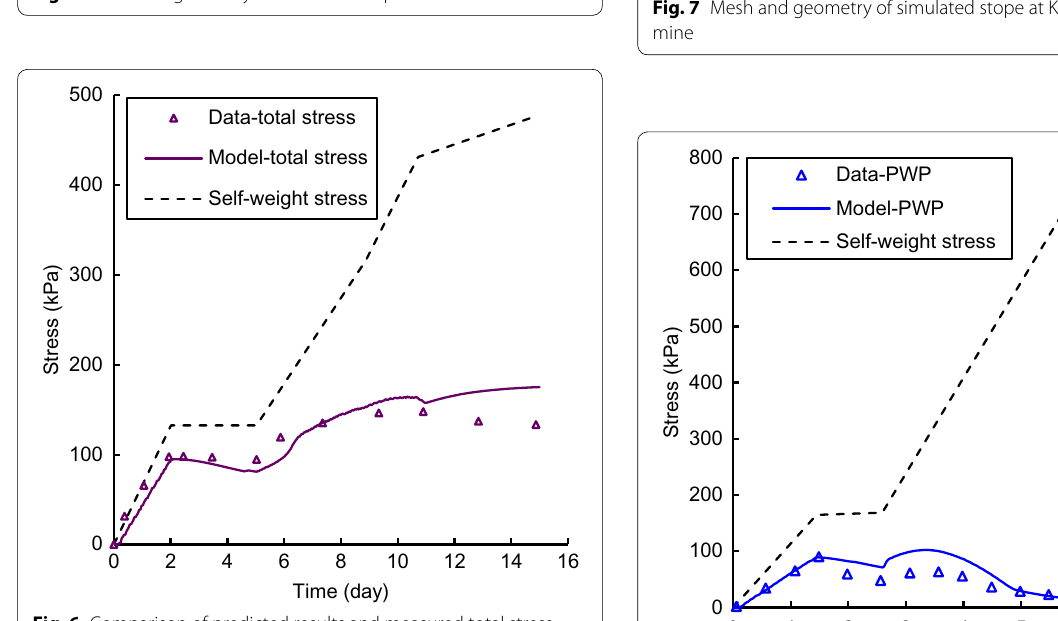
Fig. 6 Comparison of predicted results and measured total stress values at DG Mine (cement content: 7% and solid content: 70%). After 3-days of curing, the residual stope was filled with CPB with a cement content of 3% and a solid content of 70%.